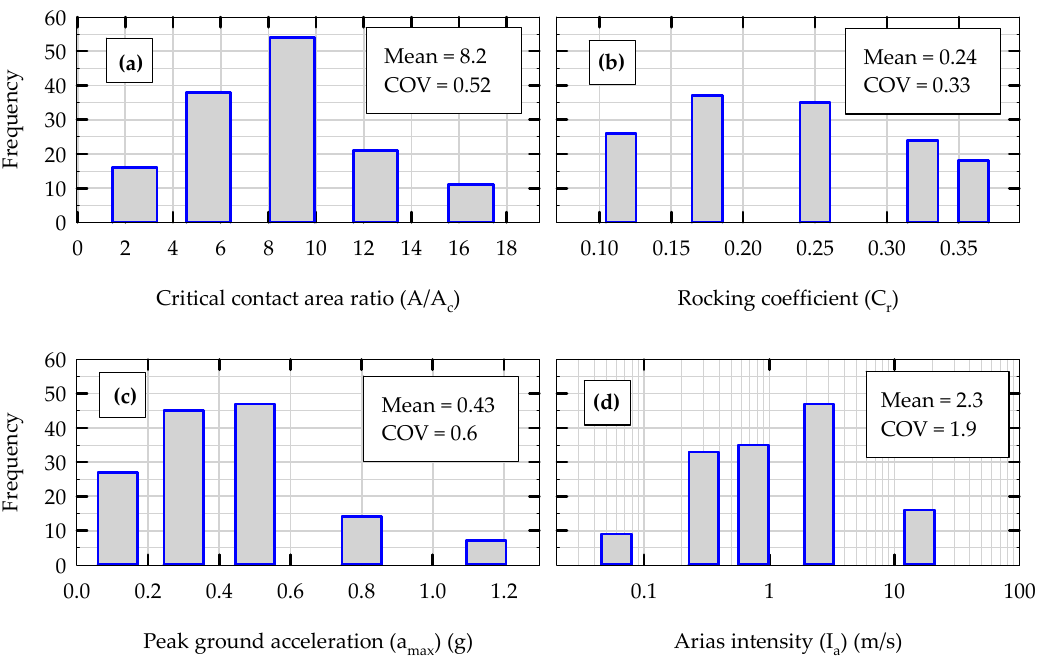
Critical contact area ratio (A/A